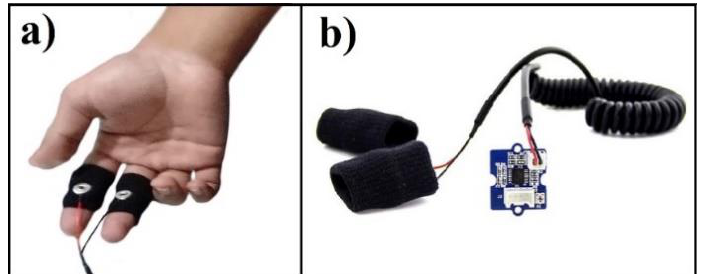
Figure 1. Galvanic Skin Response (GSR) Sensor: ( a ) location of the electrodes; ( b ) electronic card and electrodes.